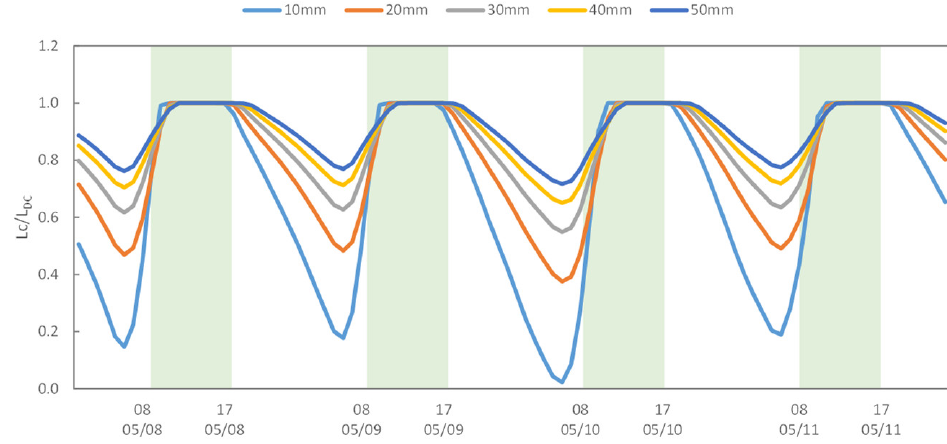
Figure 9. Operating efficiency of the PCM during the air-conditioning season.